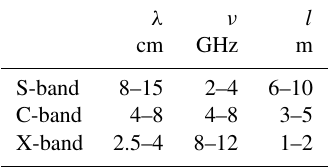
Table 2. Weather radar